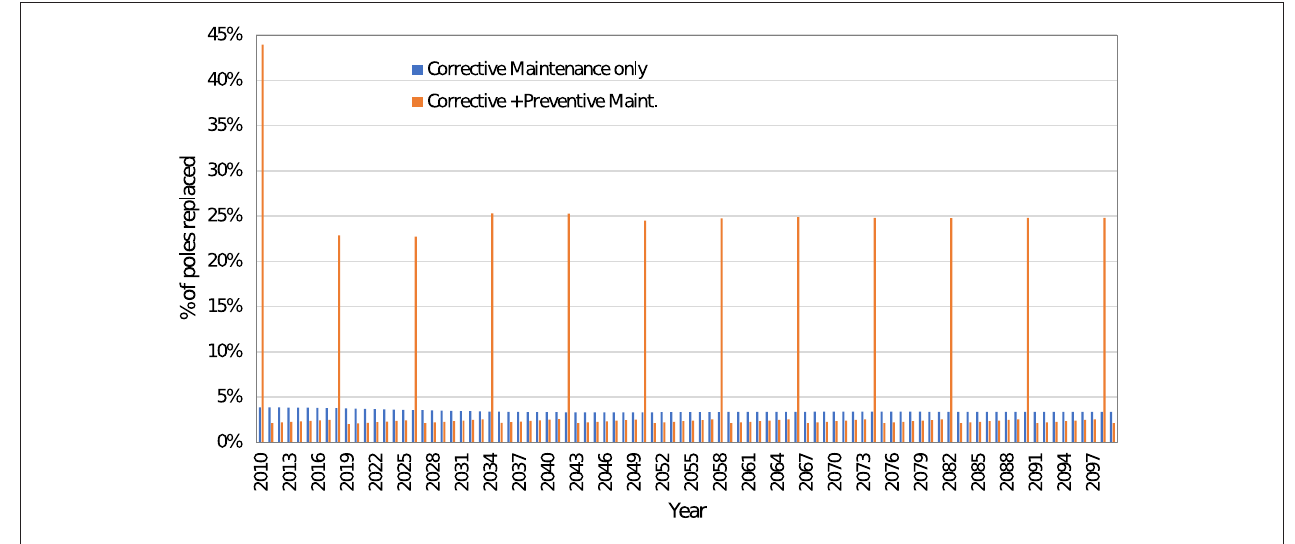
FIGURE 9 | Comparison of the number of replaced poles for corrective only and corrective + preventive replacement for Miami with no CC (8-year inspection cycle).